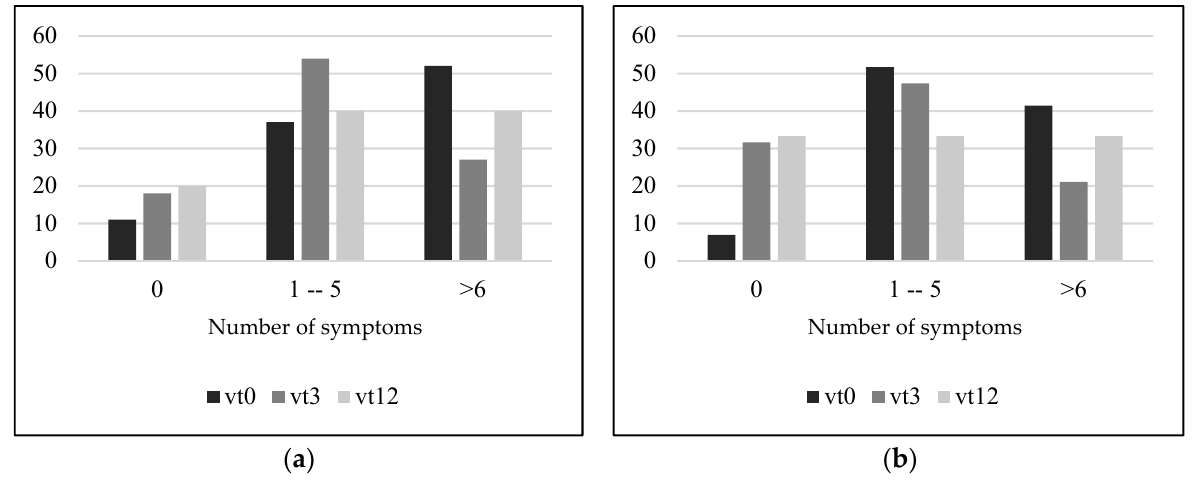
Figure 2. Percentage of adult ( a ) and children and adolescent ( b ) participants presenting 0, 1–5 or more than 6 symptoms. Vt0: visit at time 0, at diagnosis; vt3: visit after 3 months on a gluten-free diet; vt12: visit after 12 months on a gluten-free diet.